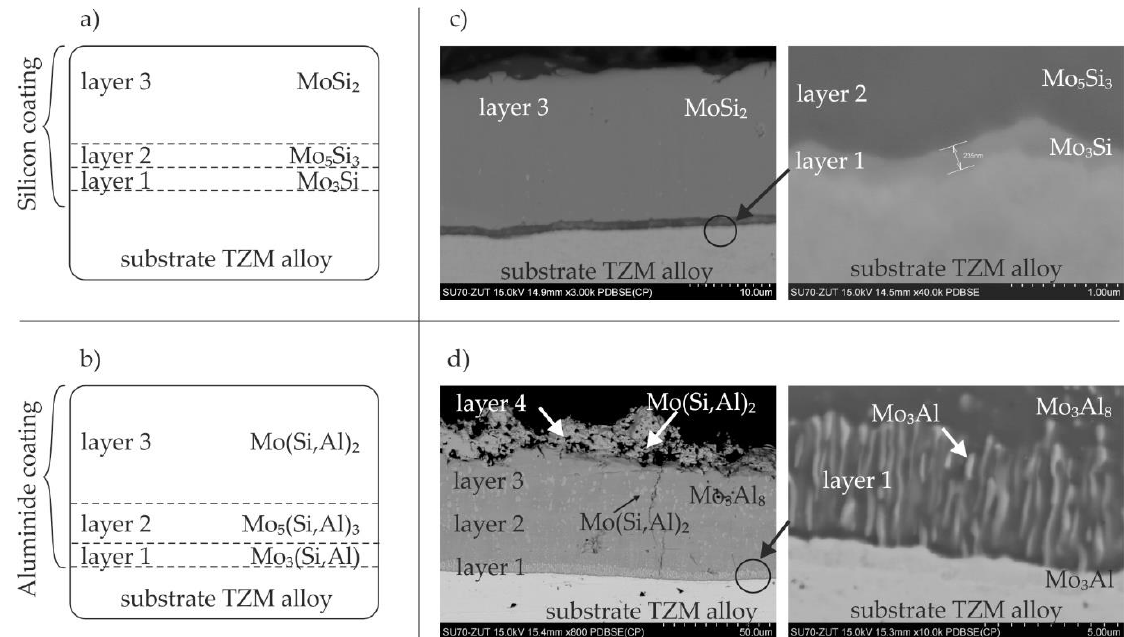
Figure 1. Graphical representation of ( a ) Si and ( b ) Si-Al coatings manufactured by the pack cementation method [5,6], and the microstructure of ( c ) Si coating and ( d ) Si-Al coating obtained by the slurry cementation process in the current studies (2 h at 1000 °C, slurry volume of 0.3 g/cm 2 ).